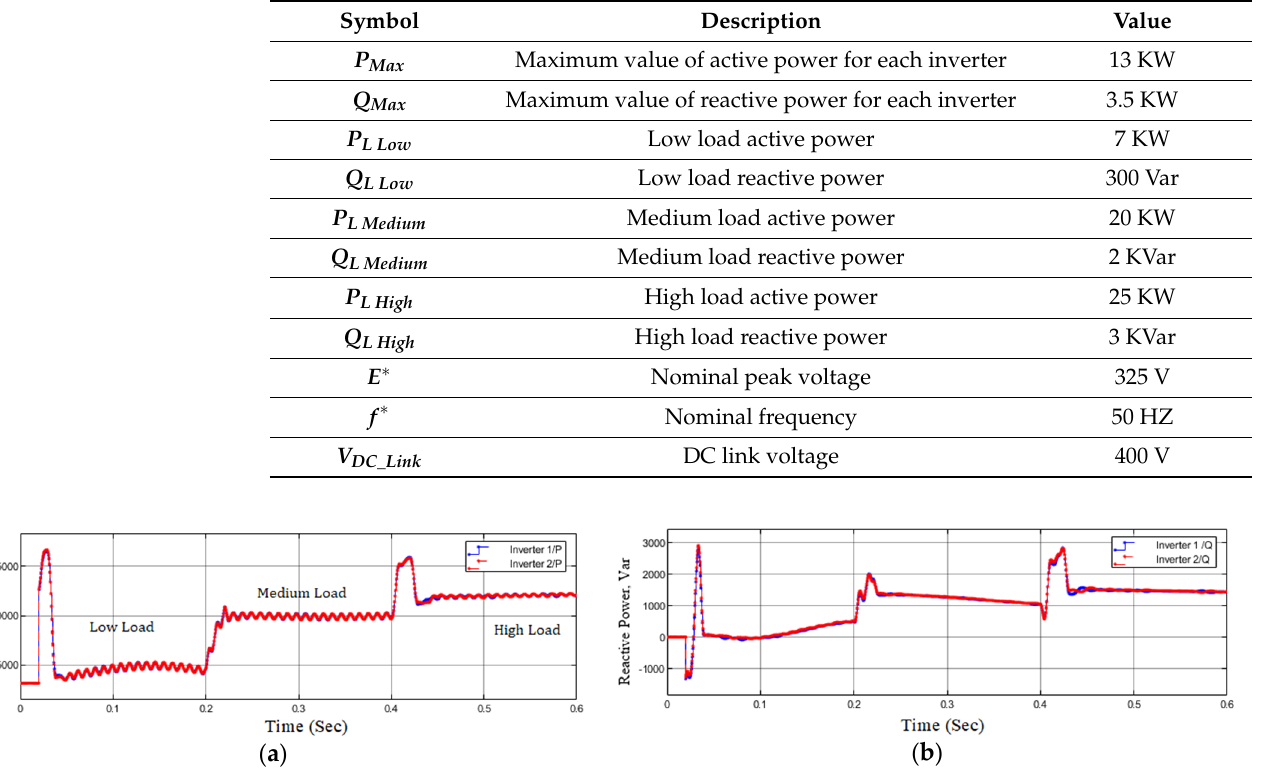
Figure 18. Output power of the inverter when low, medium, and high loads are supplied using conventional droop control for: ( a ) Active power; ( b ) Reactive power.